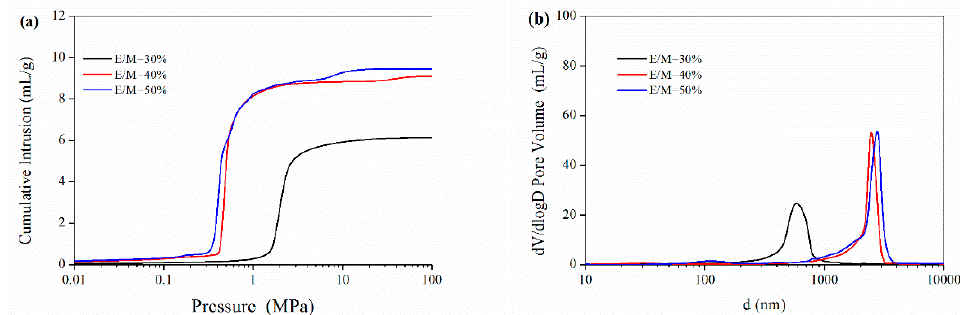
Figure 6. ( a ) Cumulative mercury intrusion traces and ( b ) Size distribution of the interconnected windows in the PolyHIPE scaffolds fabricated with different emulsifier amount.